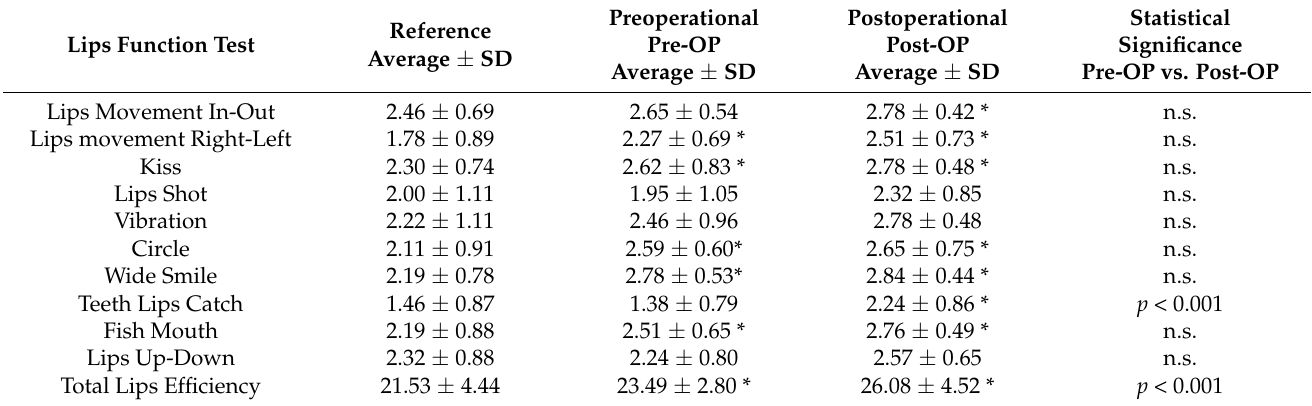
Table 4. Lip function in operated dysgnathic